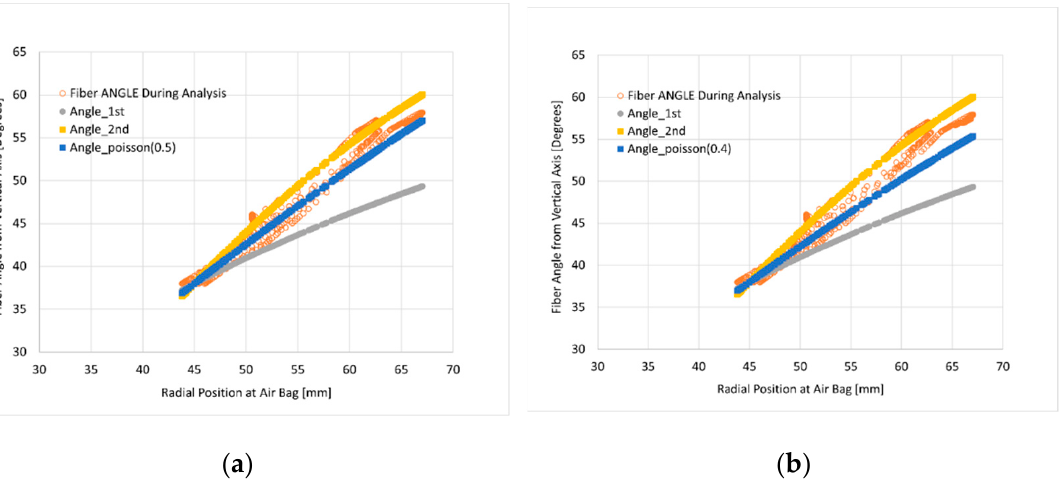
Figure 7. Angle calculation results and simulation results during inflation and compression analysis in sleeve-type air spring: ( a ) Equations (1)–(3) with Poisson’s ratio of 0.5; ( b ) Equations (1)–(3) with Poisson’s ratio of 0.4.